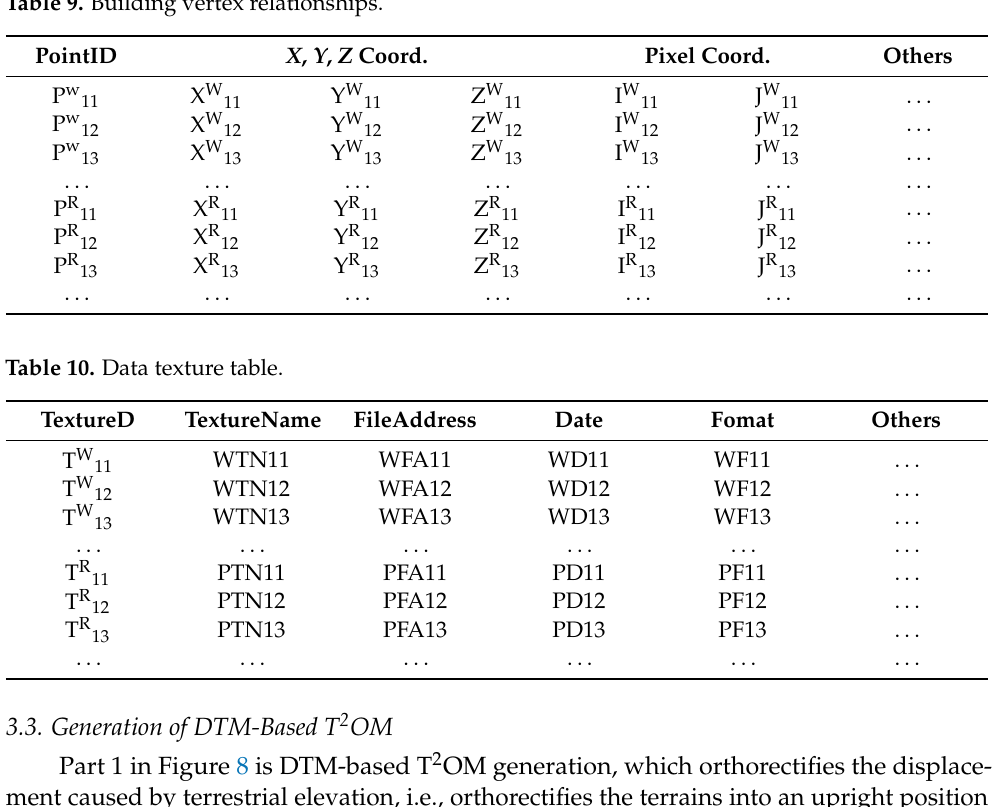
Table 9. Building vertex relationships.